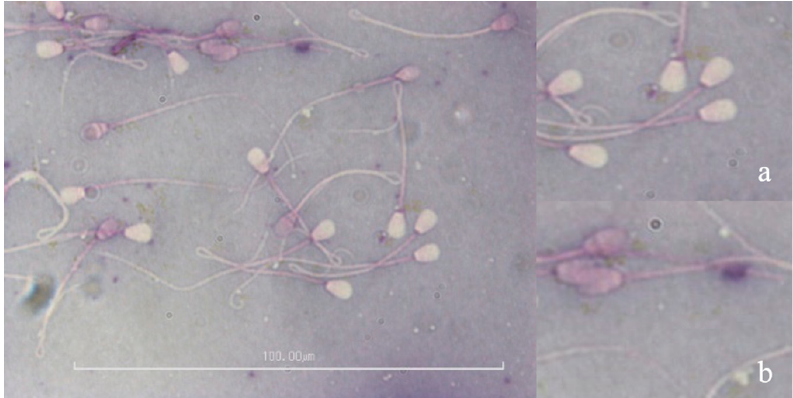
Figure 2. Image of eosin-nigrosin stained sperm showing live and dead sperm. Insets: magnified view of ( a ) live sperm, and ( b ) dead sperm.